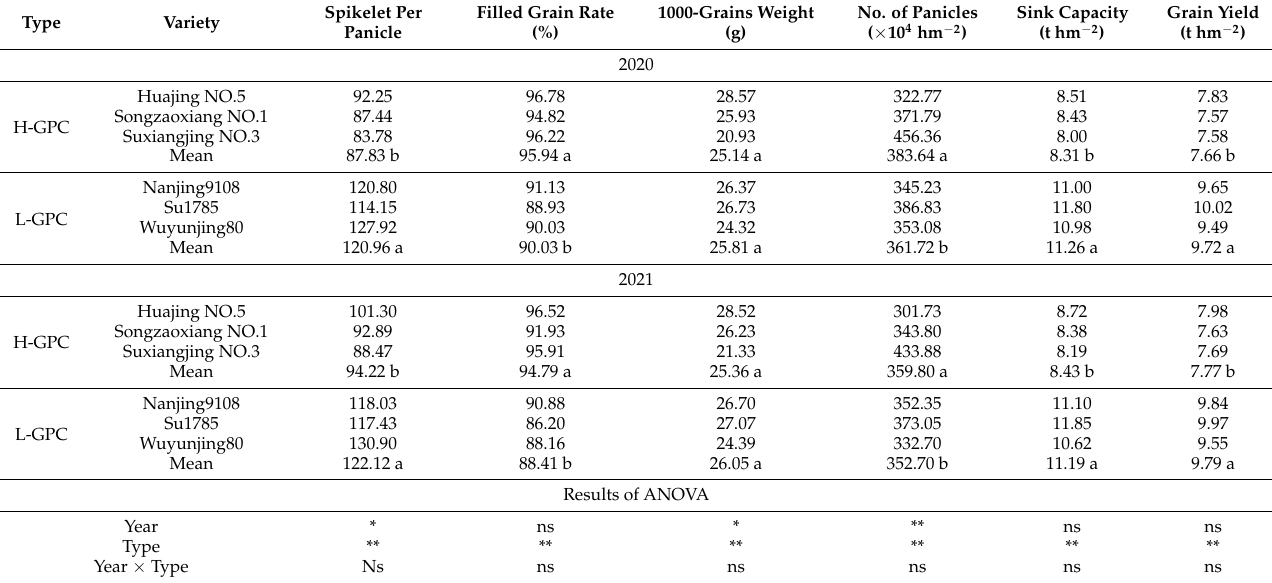
Table 2. Grain yield and yield components in 2020 and